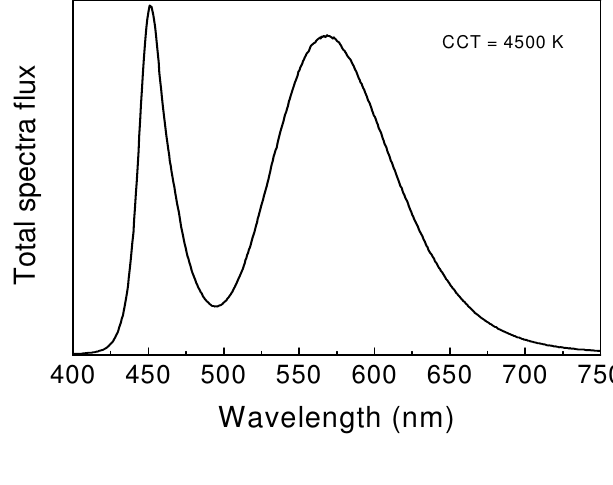
Figure 6. Emission spectrum of 1-pc white LEDs using a Li- α -sialon:Eu 2+ and a blue LED